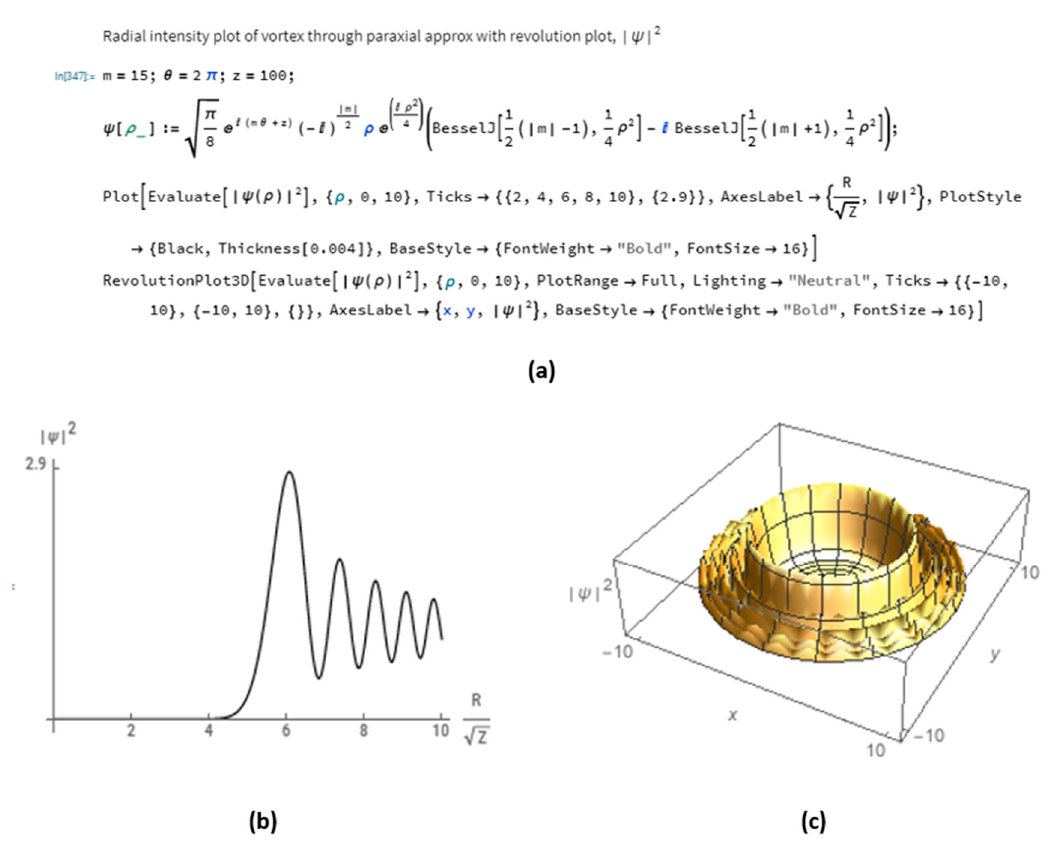
Figure 1. Vortex simulation in Mathematica. ( a ) Code of paraxial approximation to generate ( b ) the intensity plot and ( c ) the 3D pattern of a focused vortex.